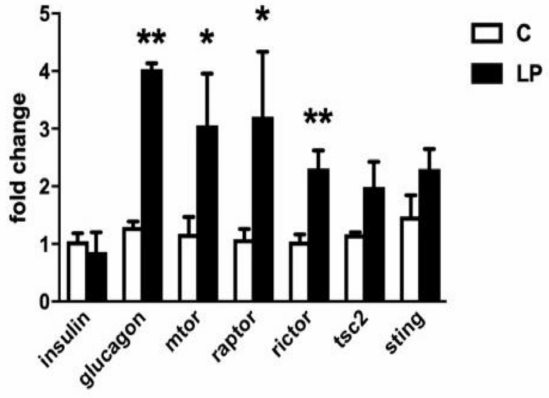
Figure 3. Fold changes relative to the expression of glyceraldehyde-3-phosphate dehydrogenase (GAPDH) in the expression of mRNA encoding insulin, proglucagon, mTOR, Raptor, Rictor, TSC2 or STING within isolated islets from pancreata of 7-day old mice exposed in utero to control (C, open bars) or LP (closed bars) diet. Values show mean ± SEM; n = 3–7 samples from different animals per group, * p < 0.05, ** p < 0.005 vs. control